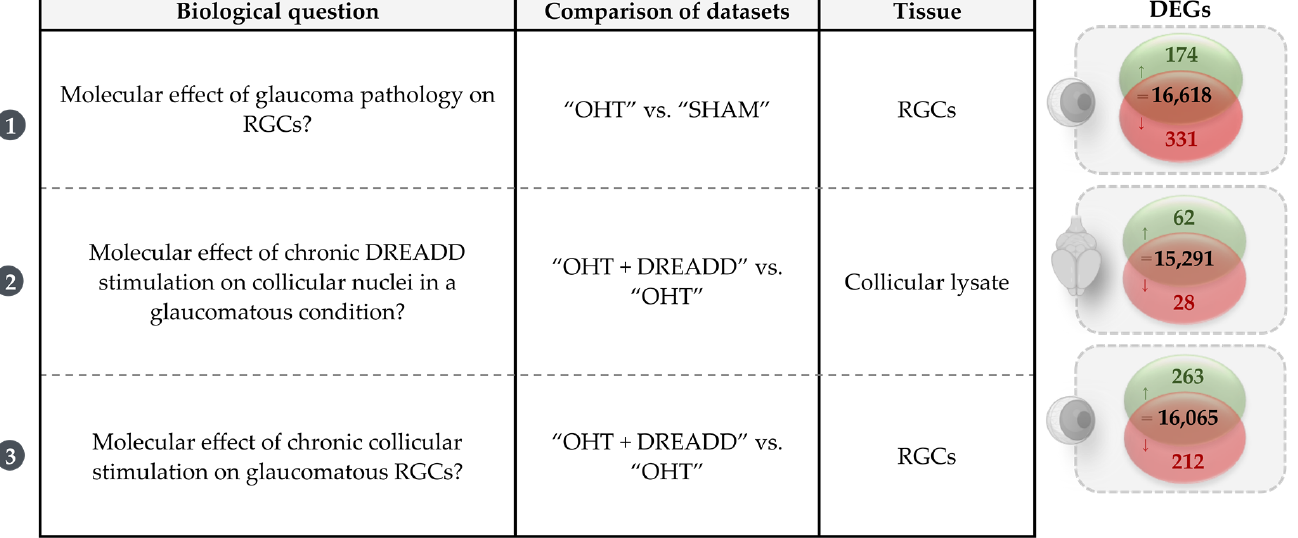
Figure 3. Overview of the biological questions uncovered in this study and the detected differentially expressed genes (DEGs) of these dataset comparisons. DEGs were identified based on the ampli- tude and statistical significance of the log fold change expression level (FDR < 0.1 and |log fold change| > 1.3 for the RGC samples vs. > 0.5 for the collicular samples). Up- and downregulated DEGs are shown in green and red, respectively, together with the unaltered genes in